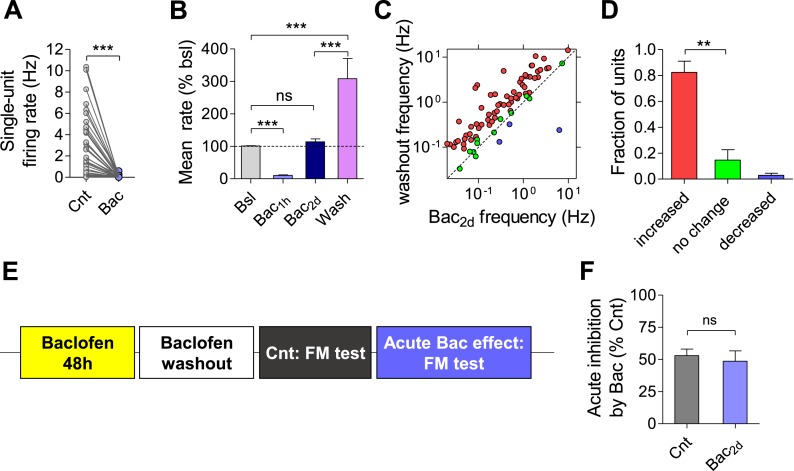
Prolonged exposure to baclofen does not cause reduction in the sensitivity of synapses and neurons to the GABABR-mediated inhibition.(A) Baclofen (10 µM) was added to a culture dish for 2 days. The medium from this dish was applied to a new MEA. The reduction of firing rate by pre-incubated baclofen was 4 ± 1% (n = 50, p < 0.0001), similar to the one observed by fresh baclofen (Figure 1G). (B) Washout of baclofen causes an increase in mean firing rate relative to both baseline and after 2 days baclofen incubation (relative to baseline: 306% ± 67, relative to 2 days baclofen: 296% ± 38; n = 77 units). (C) Per unit correlation between firing rates before and after washout of baclofen. Colors represent units that significantly increased (red), decreased (blue), or remained stable (green) as determined by bootstrapping. Note log scale of both axes. Same units as in (B). (D) Summary of data in (C). (E) Experimental protocol used for determining acute effect of baclofen after 2 days incubation with 10 µM baclofen and subsequent washout. (F) Baclofen (1 µM) decreased FM staining to 52 ± 5% (n = 18) and 49 ± 8% (n = 8) relative to control with and without 2 days incubation with baclofen, respectively (p = 0.89).